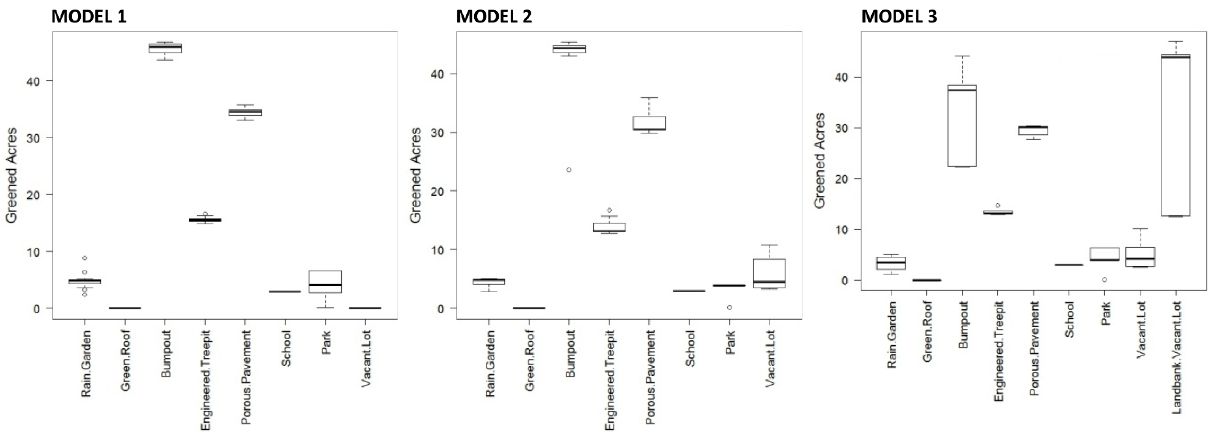
Figure 11. Results of model runs in terms of net greened acres after 30 years, by GI